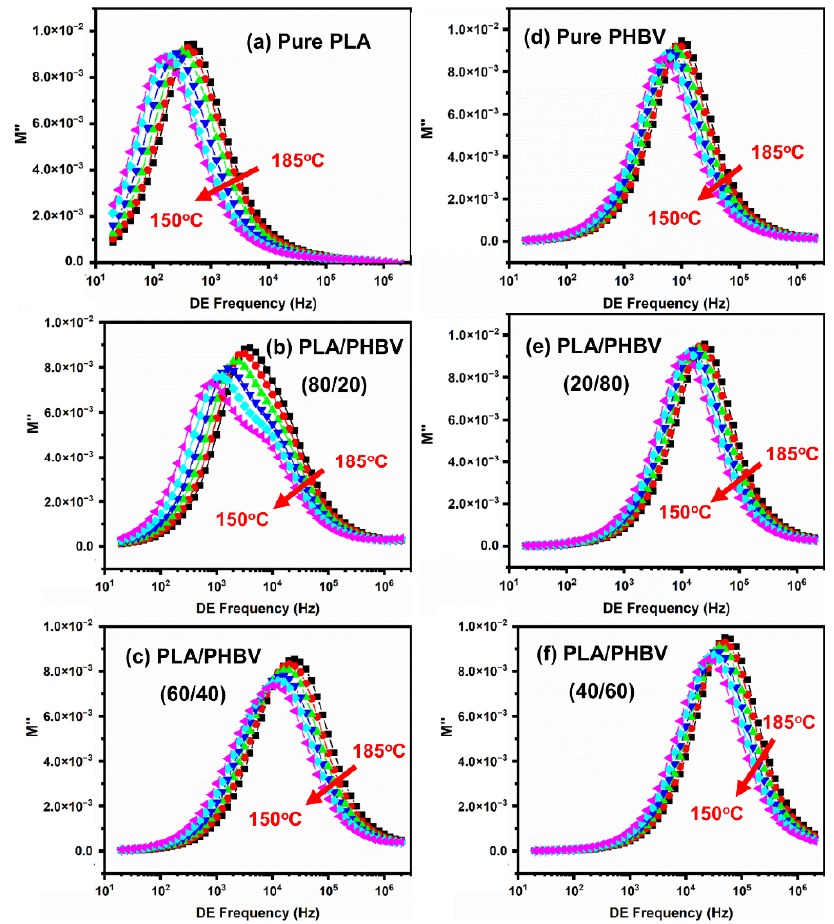
Figure 16. Dielectric loss modulus M″ as a function of frequency in the temperature range of 185 to 150 °C for ( a ) pure PLA; ( b ) PLA/PHBV (80/20); ( c ) PLA/PHBV (60/40); ( d ) Pure PHBV; ( e ) PLA/PHBV (20/80); ( f ) PLA/PHBV (40/60).